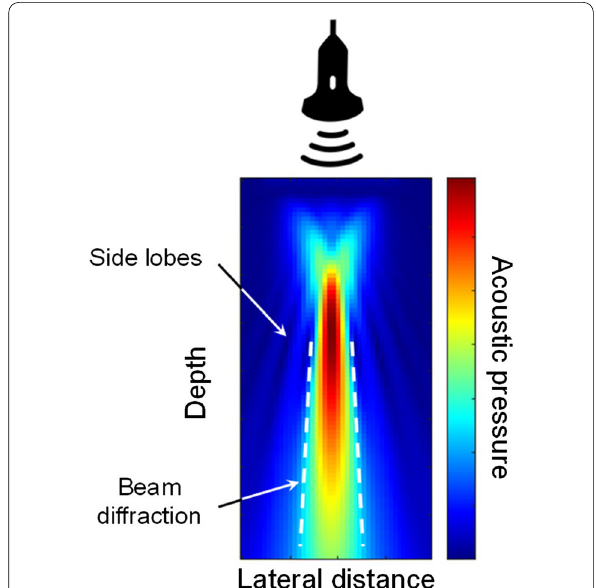
Fig. 11 Typical diffraction pattern of an ultrasound probe and presence of side lobes associated with the beam forming reconstruction method, and finite dimension of the transducer aperture (typically determined by the number of transducer elements used at emission and reception). Notice that diffraction and side lobe characteristics are defining the point spread function property schematized in Fig. 4. This example illustrates the acoustic pressure distribution of a typical ultrasound beam produced by an array transducer. Specific beam forming strategies are used to reduce side lobes and multiple focuses improve the uniformity of the acoustic pressure distribution. Nevertheless, wave diffraction occurs and should be compensated to achieve reliable QUS measurements. Because the magnitude of compression waves is not uniform in the lateral ( x -axis) and axial ( y -axis or depth) directions, calibration with